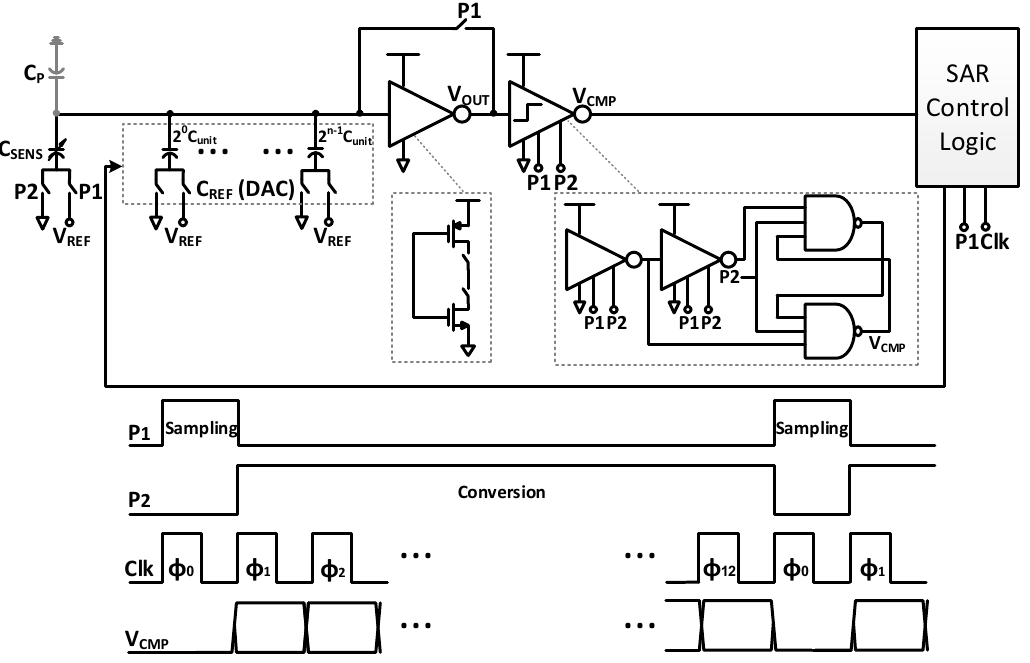
Figure 4. Readout circuit with associated timing diagram.